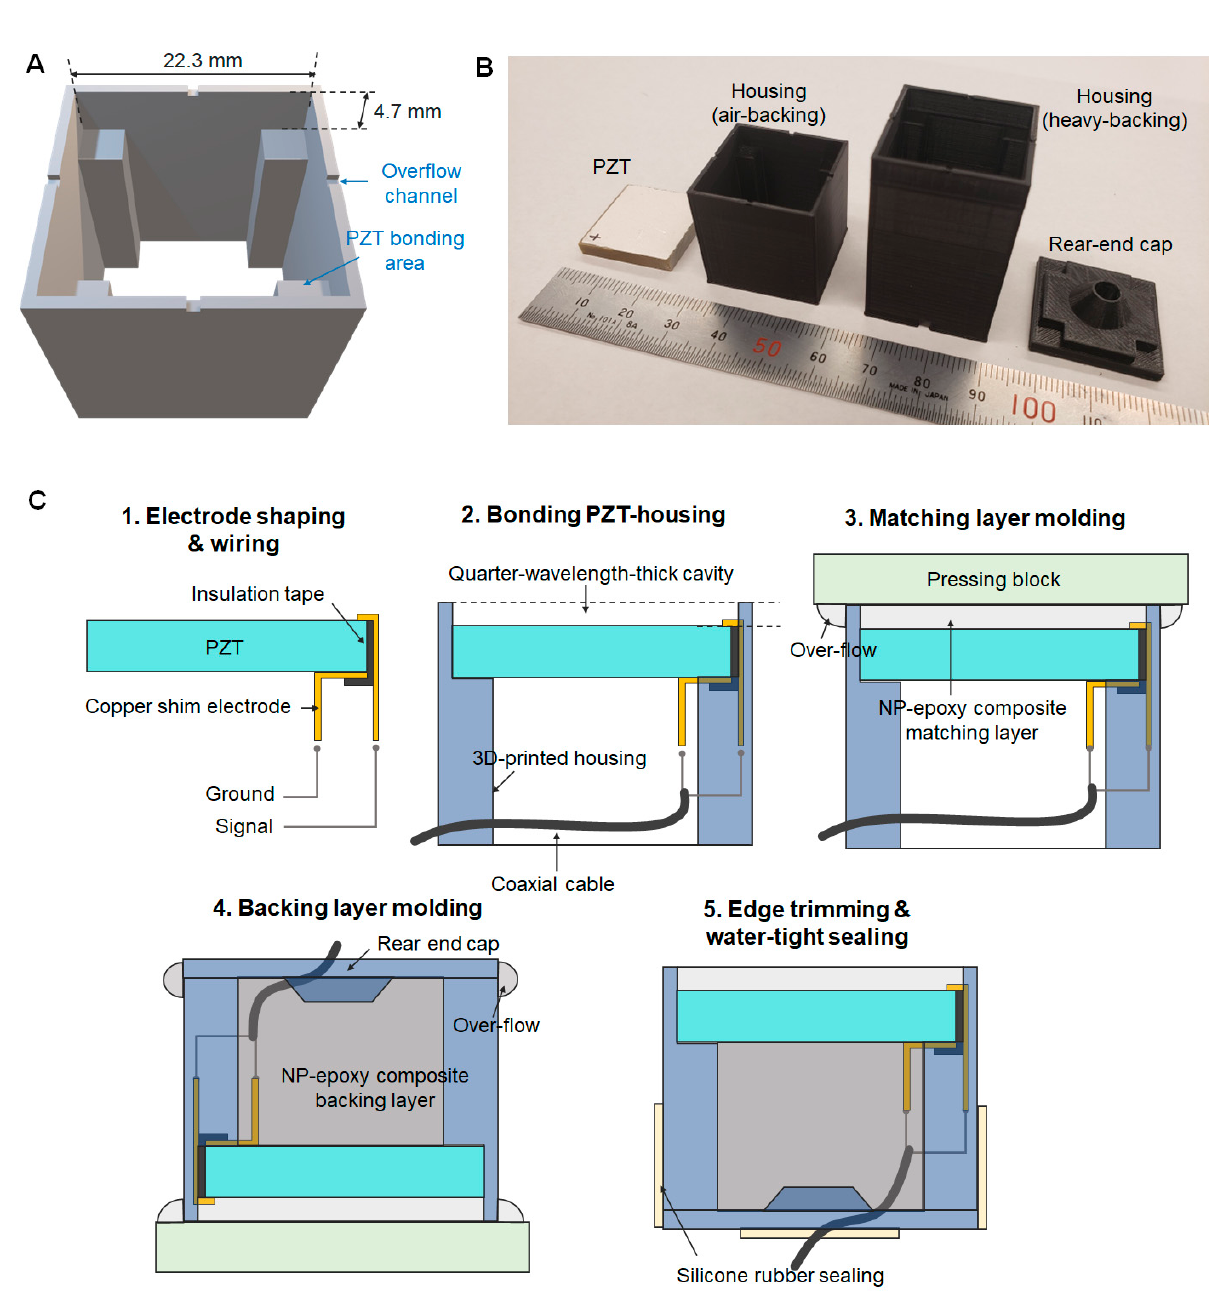
Figure 2. A modeled STL file for 3D-printing ( A ), 3D-printed parts ( B ), and the rapid prototyping procedure ( C ); The stage 4. backing layer molding can be omitted for the air-backing design .